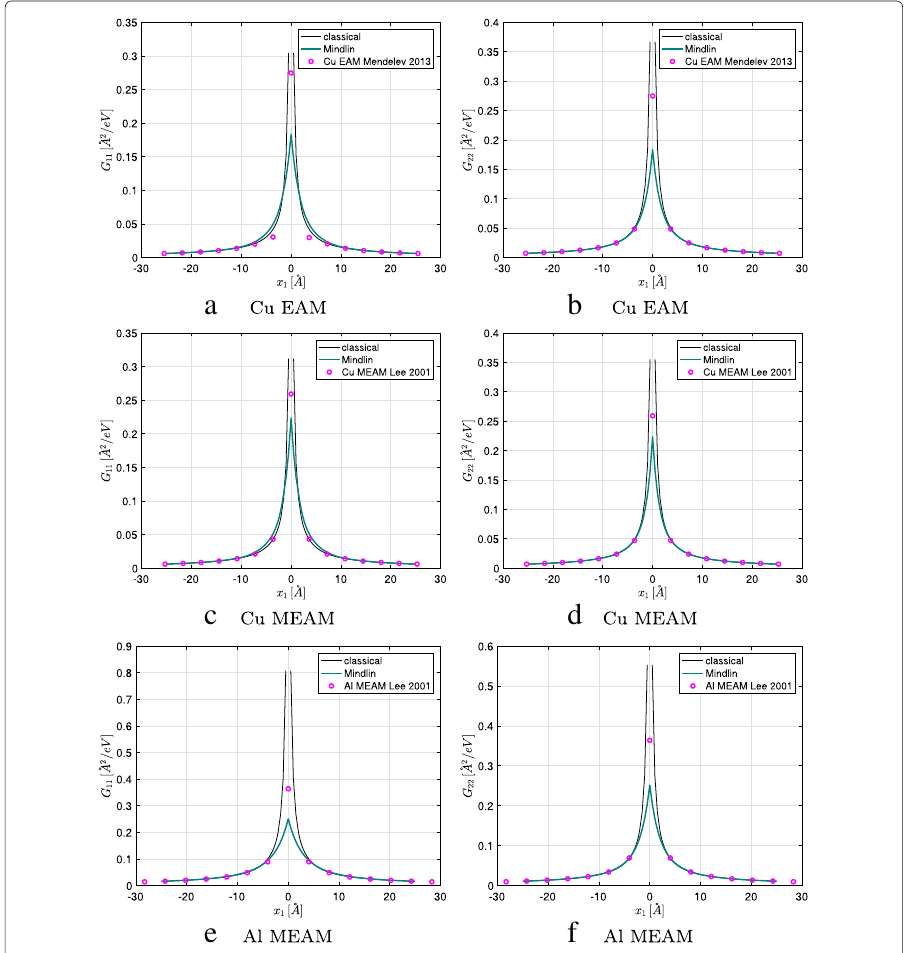
Fig. 4 Components of the Green tensor for fcc Al and Cu, and comparison to atomistic calculations obtained from the interatomic potentials Lee (2014) and Mendelev (2014). a - b Cu for EAM potential (Mendelev 2014). c - e Cu for MEAM potential (Lee 2014). e - f Al for MEAM potential (Lee